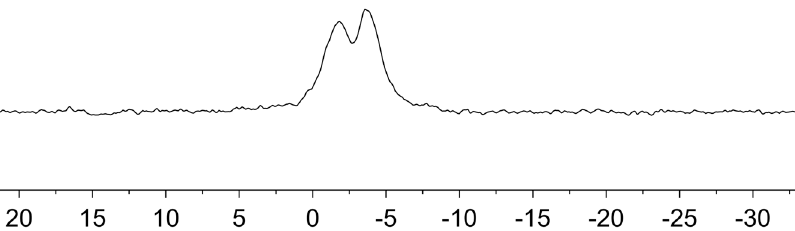
Figure 3. The signal arising from the [Cu(BIPHEP)(6-Mebpy)] + cation in the 31 P{ 1 H} NMR spectrum (202 MHz, acetone- d 6 , 298 K) of [Cu(BIPHEP)(6-Mebpy)][PF 6 ].